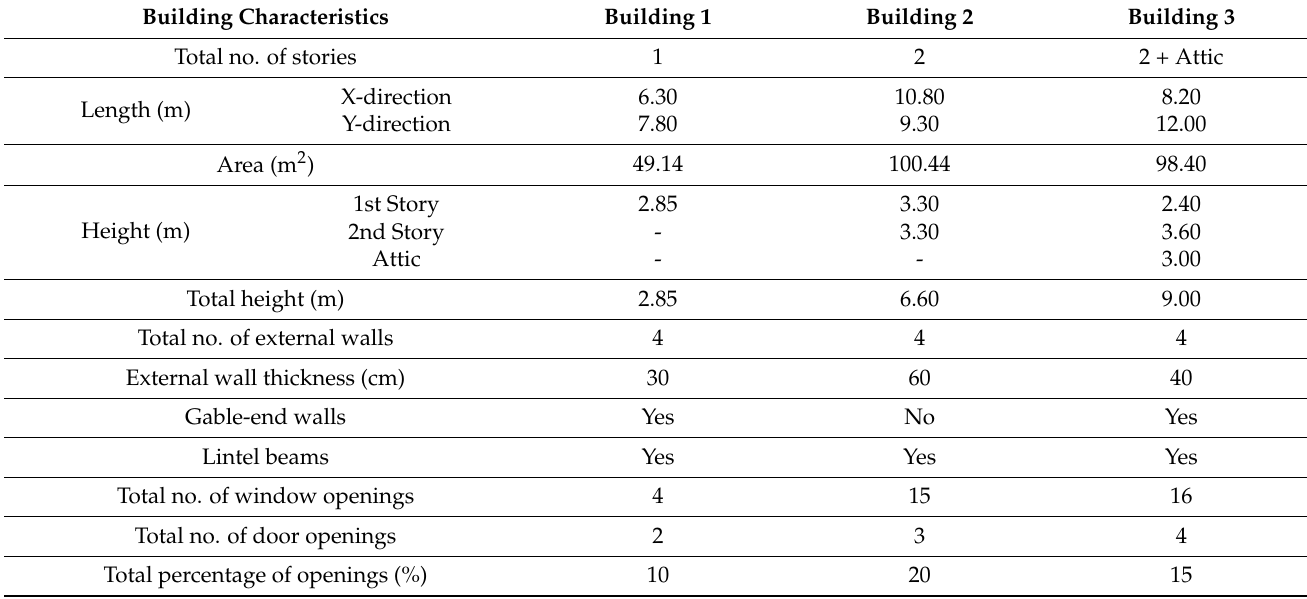
Table 1. Building characteristics and